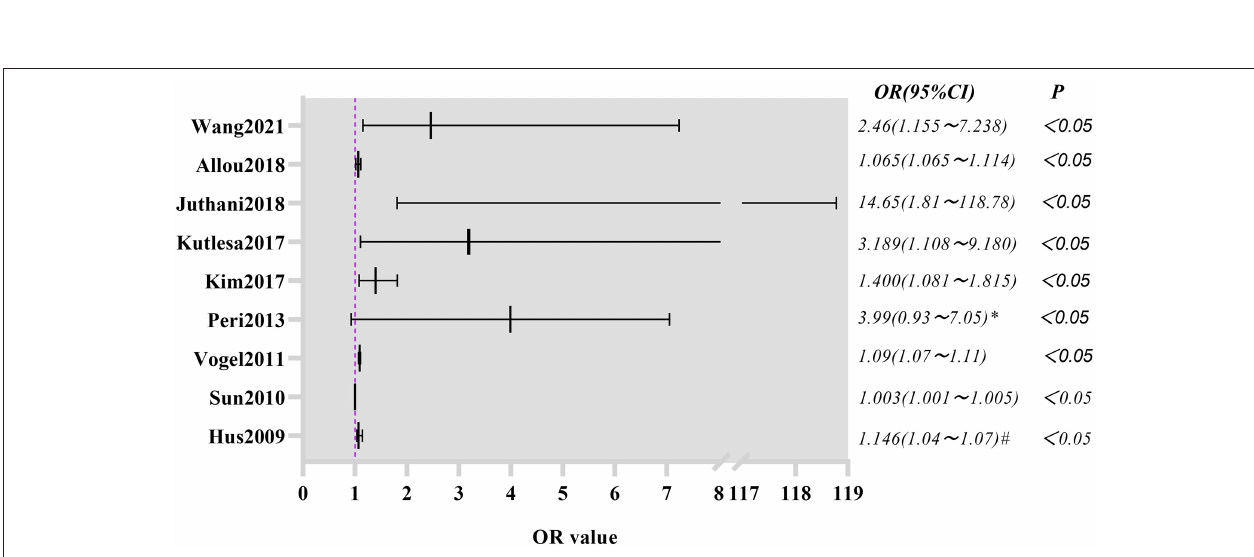
FIGURE 6 | Forest plot of the risk of nosocomial infection due to ECMO duration.